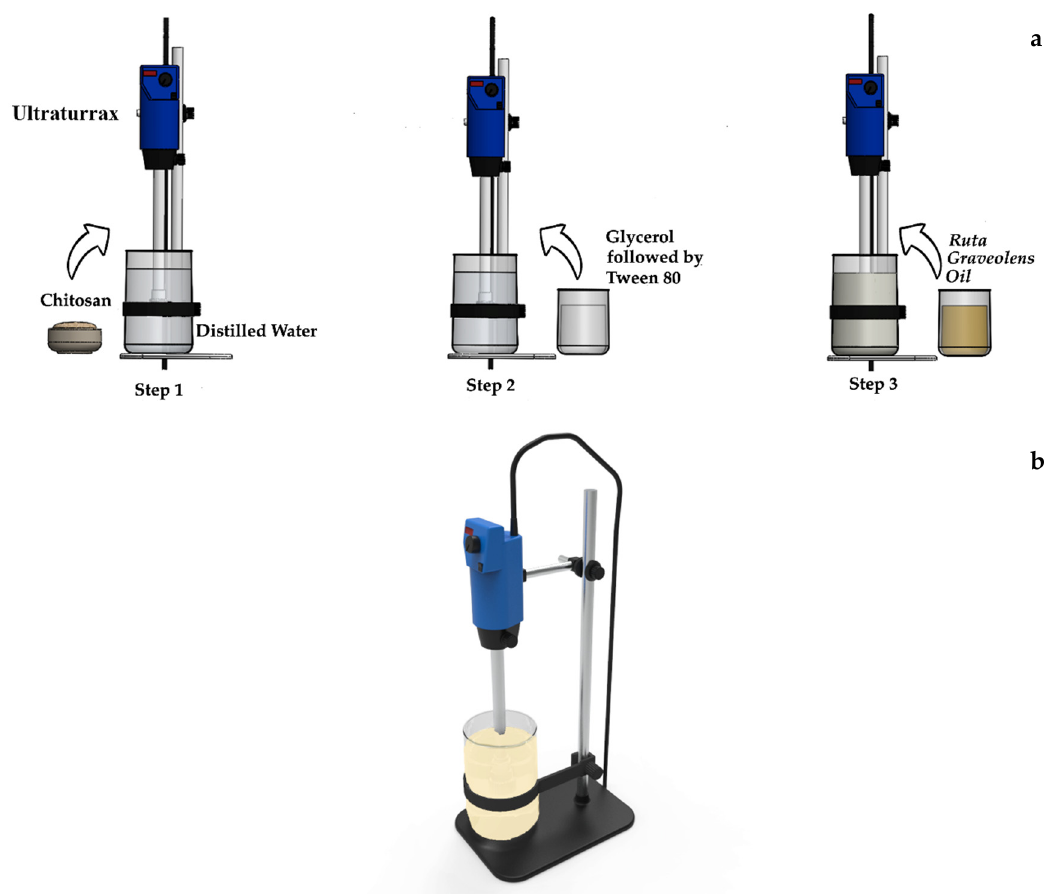
Figure 1. Preparation of film-forming emulsions, ( a ) A schematic view of the different steps emulsions preparation process, ( b ) a detailed picture of the emulsion preparation setup.